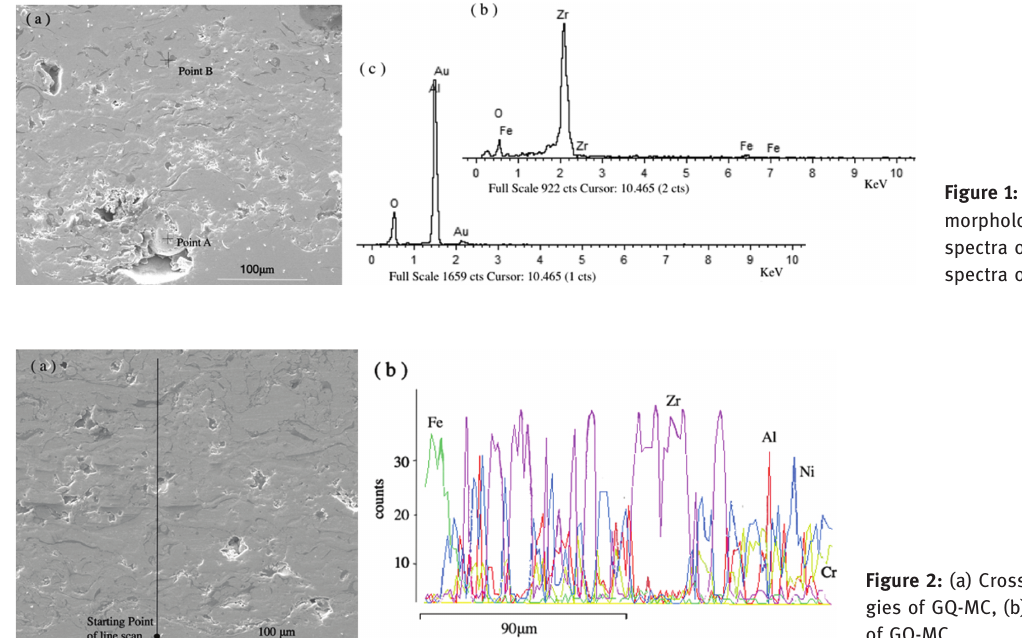
Figure 2: (a) Cross-sectional morpholo- gies of GQ-MC, (b) EDS line scan profile of GQ-MC.